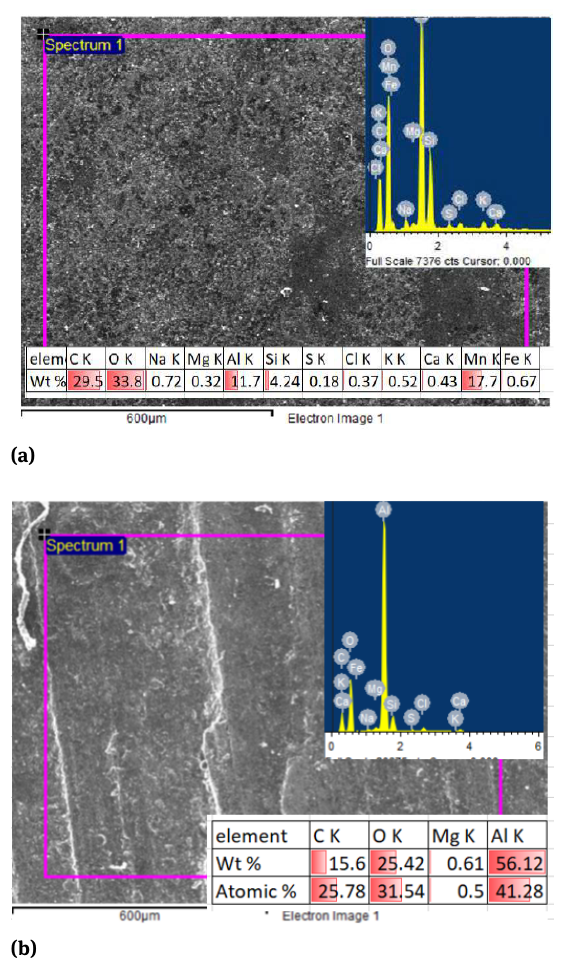
Figure 8: SEM graphs at the surface